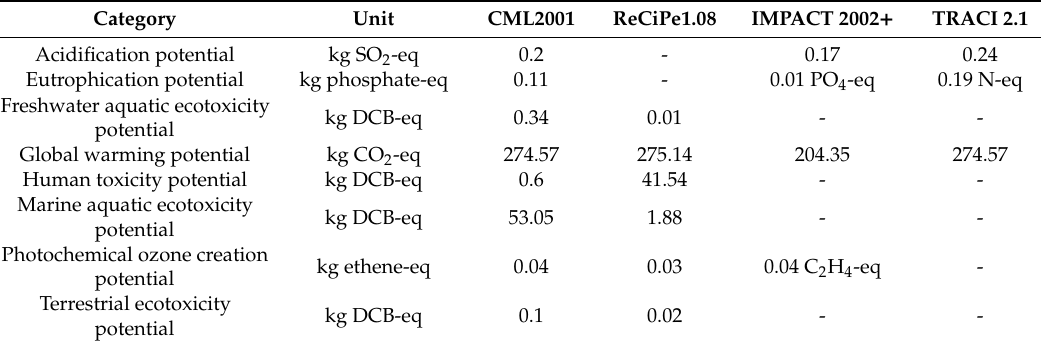
Table 5. Sensitivity analysis of di ff erent assessment methods.